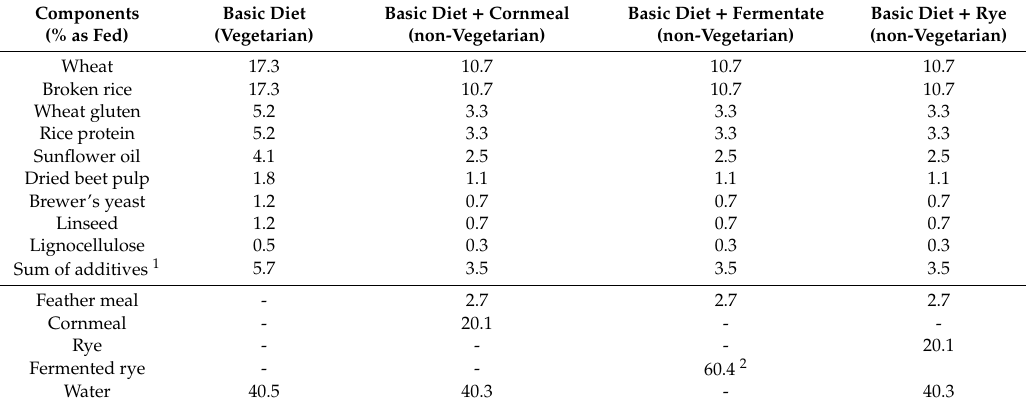
Table 1. Components of the vegetarian diet (basic diet) and the vegetarian diet supplemented with feather meal as well as either cornmeal (basic diet + cornmeal), fermented rye (basic diet + fermentate) or rye (basic diet +